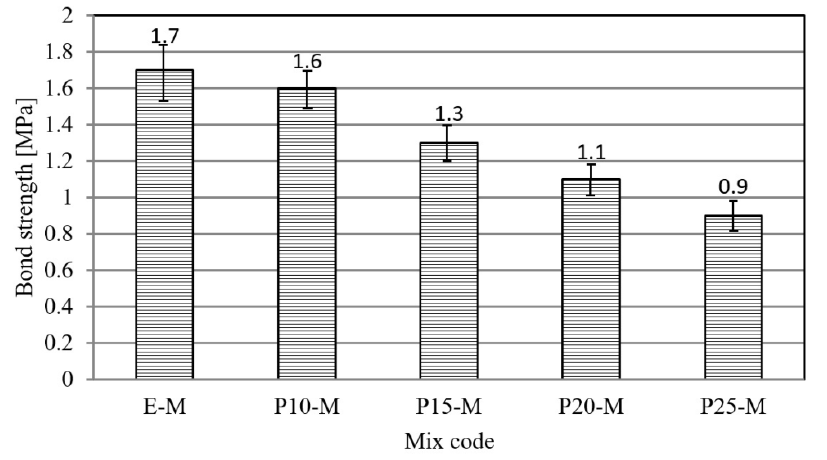
Figure 3. Drying shrinkage development of mortar mixtures.